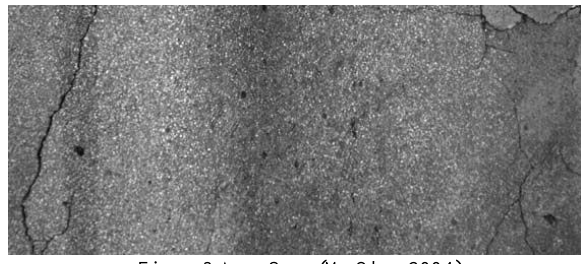
Figure 3 Area Scan (McGhee